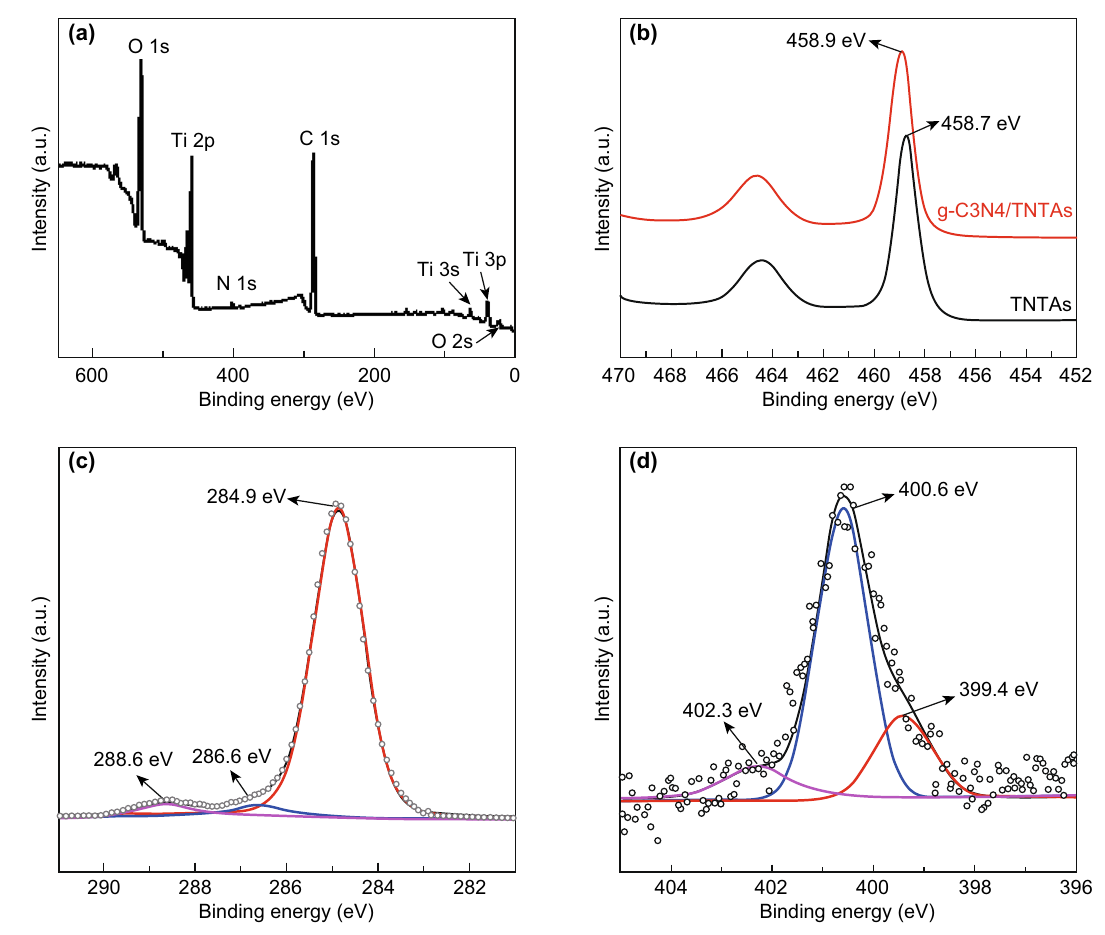
Fig. 6 XPS spectra of g-C 3 N 4 /TNTAs: a survey scan, b Ti 2p, c C 1s, and d N 1s